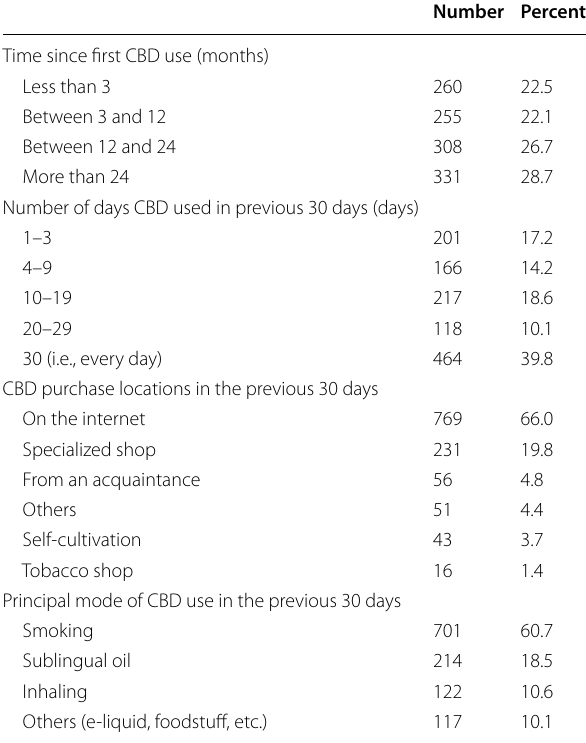
Table 2 Pattern of cannabidiol use in the whole study sample ( n =